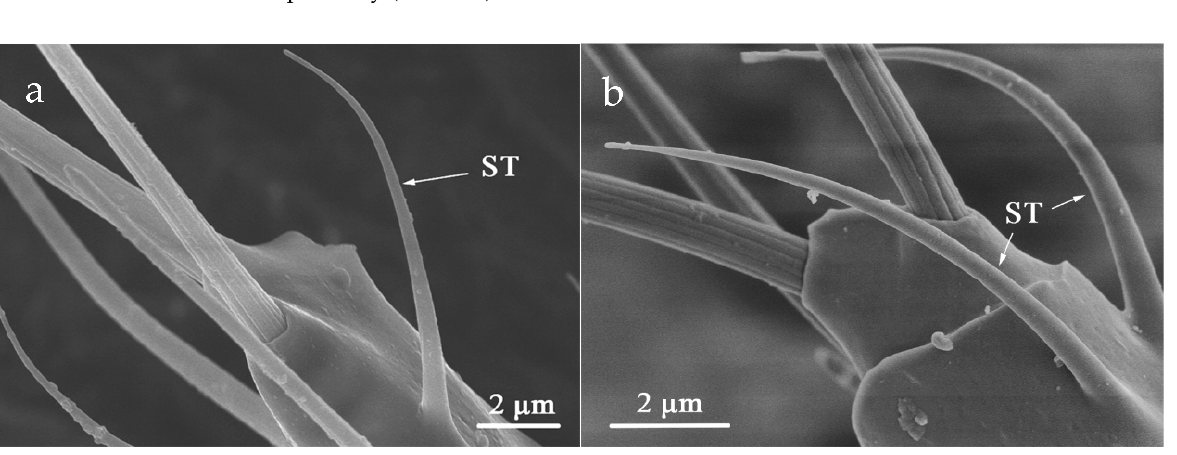
Figure 10. Sensilla campaniformia (SCa) on the pedicel ( a ) and shown at higher magnification ( b ) in S. kaszabi .